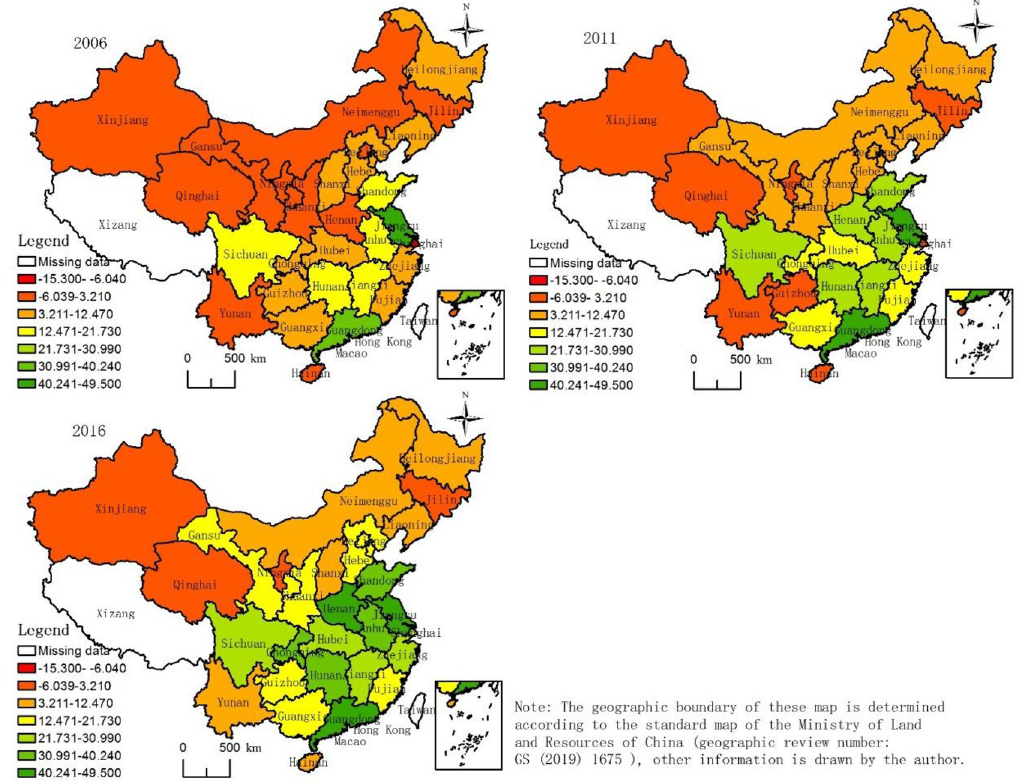
Fig 7. Map of spatial distribution of the degree of coupling between China’s provincial high-tech industry and regional economy.